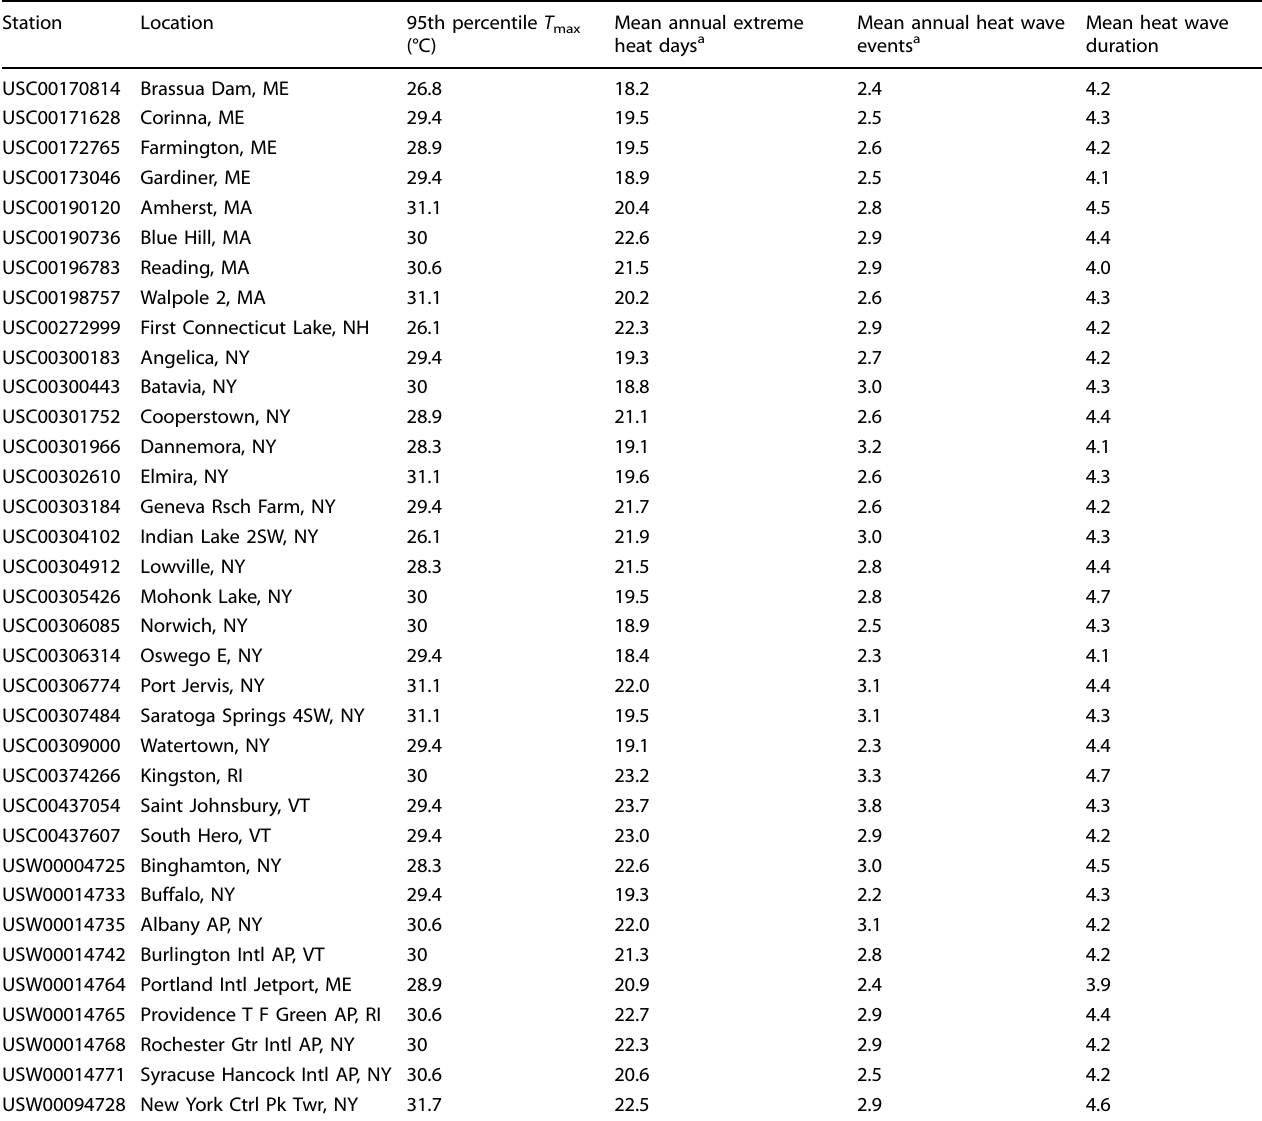
Table 2. Northeast GHCN stations used in the study and their mean 95th-percentile T max , mean annual extreme heat days (days with T max over the 95th-percentile), mean annual number of heat wave events (three or more consecutive extreme heat days), and mean duration of heat wave events 1980 – 2018.